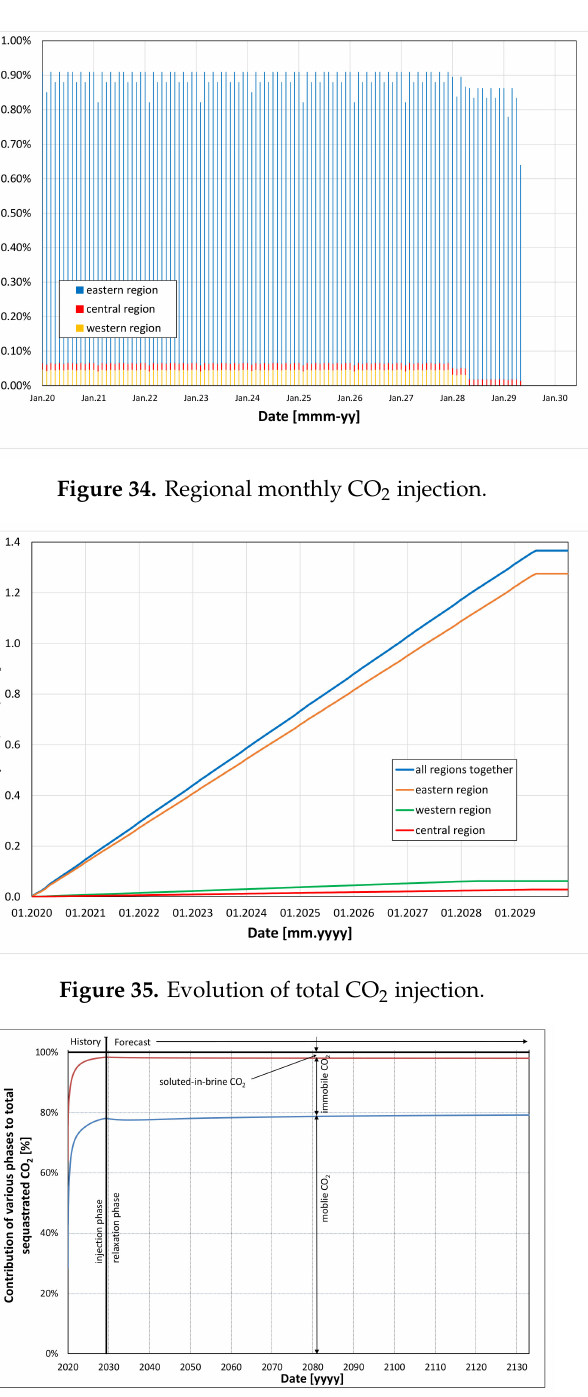
Figure 36. Contribution of trapping mechanisms to the total